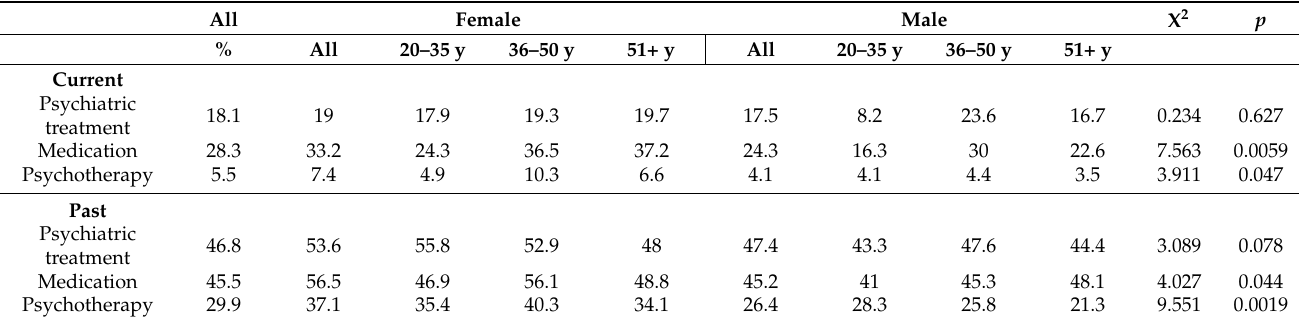
Table 3. Mental health care utilization in sexes and age groups in percent.